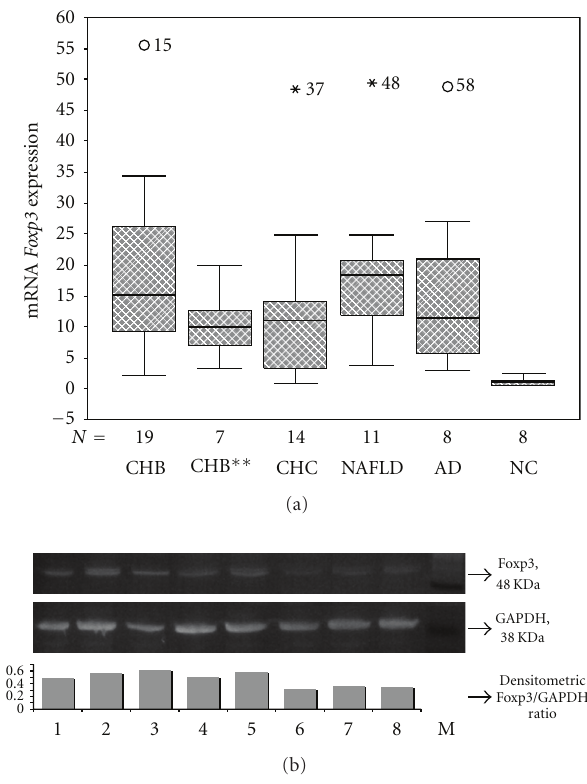
Figure 1: Expression of Foxp3 in di ff erent hepatic diseases. (a) Boxplot diagram of the relative expression of Foxp3 in the di ff erent disease subgroups (CHB: chronic HBV hepatitis, CHB ∗∗ : chronic HBV hepatitis at relapse, CHC: chronic HCV hepatitis, NAFLD: non-alcoholic fatty liver disease, AD: autoimmune dis- eases/autoimmune hepatitis and primary biliary cirrhosis, and NC: normal controls). (b) Western blot analysis of the expression of FOXP3 and GAPDH. Lane 1: patient with CHC; Lanes 2 and 3: patients with CHB; Lane 4: patient with NAFLD; Lane 5: patient with autoimmune hepatitis; Lanes 6–8: normal controls; M: SeeBlue Plus2 Prestained Standard (Invitrogen,